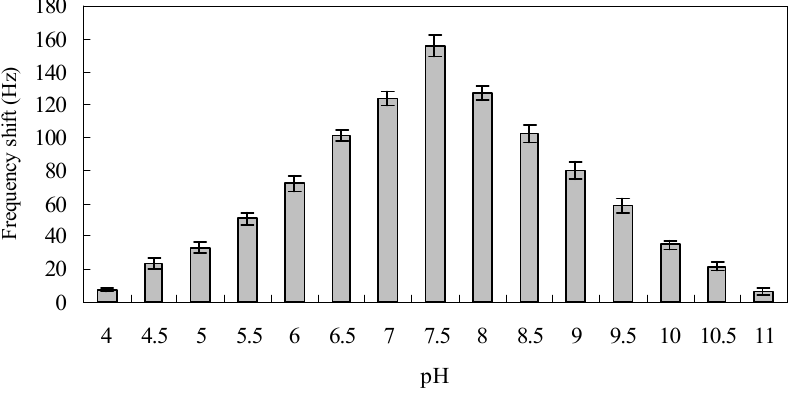
Figure 5. Effect of the buffer pH on the frequency shifts during signal amplification procedure, frequency shift under the conditions: 2×10 -9 M positive control and 0.6 mg/mL Au nanoparticles at 37 °C. Error bars indicate the standard deviation